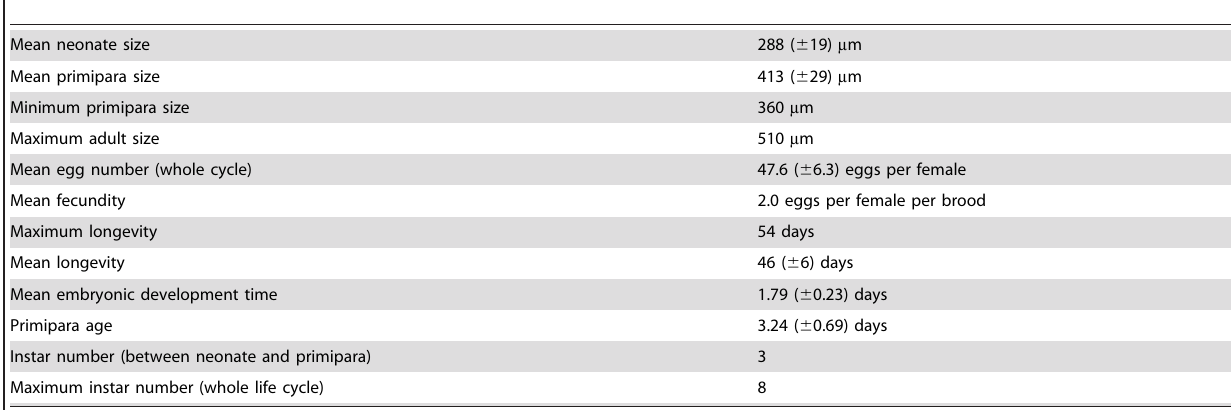
Table 1. Life cycle data for A. iheringula (Cladocera, Aloninae) from laboratory cultures at 25( 6 1) u C.